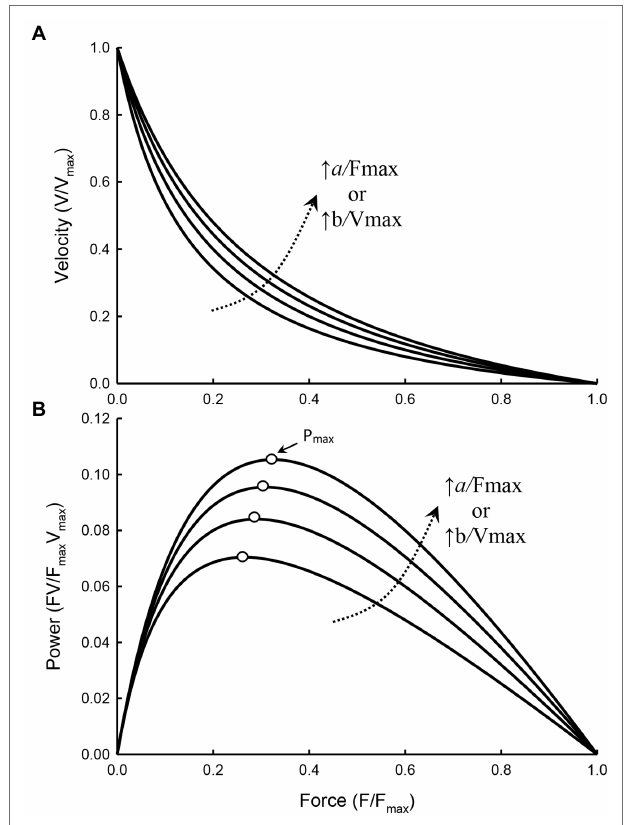
FIGURE 3 | Force–velocity (A) and force–power (B) curves with the value of a /F max and b /V max increasing from 0.15, 0.2, 0.25, to 0.3, resulting in a decrease in the curvature of the force–velocity curves (i.e., less curved) and an increase in P max of the force–power curves. The force at which P max occurs (open symbols) also increases as the curvature